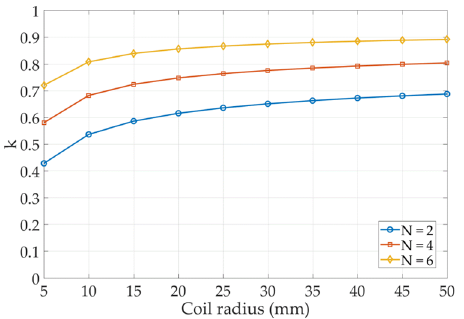
Figure 9. Coupling coefficient variation with coil radius and the number of turns.